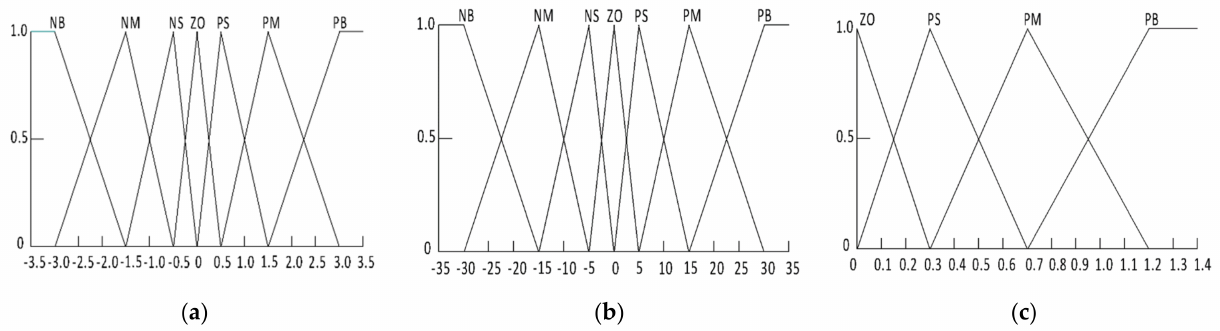
Figure 3. Membership function design for FSM. ( a ) Membership function of lateral deviation; ( b ) Membership function of heading deviation; ( c ) Membership function of gain